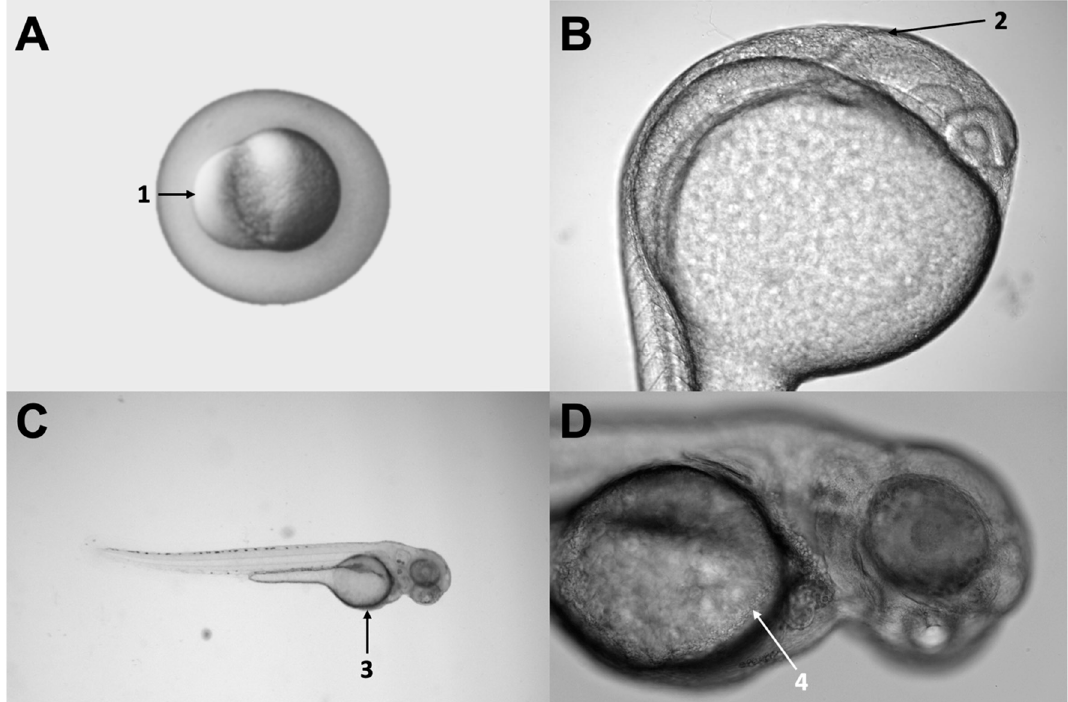
Figure 2. Different injection sites used in the articles evaluated. Panel ( A ) shows a three hour-post- fertilization (hpf) zebrafish embryo, indicating the injection site (number 1) used by Pudelko [88]. Panel ( B ) shows a 24 hpf larva, indicating the midbrain-hindbrain boundary (number 2), a relevant anatomical landmark, and a common injection site used at a different stage by Rampazzo, Wenger, and Banasavadi-Siddegowd (7 pf, 2 pf, and 36 hpf, respectively) [86,87,89]. Panel ( C ) shows a 48 hpf larva, indicating the yolk sac (number 3), which was the injection site used by Wrobel [90]. Finally, panel ( D ) shows a zoom-in of the same larvae, denoting the yolk sac and the duct of Cuvier in more detail (number 4). Original pictures were taken by the authors of this review.